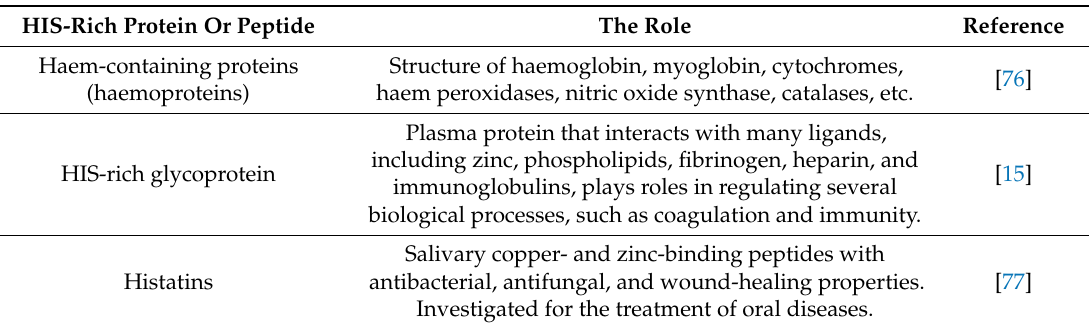
Table 2. HIS-rich proteins and peptides.